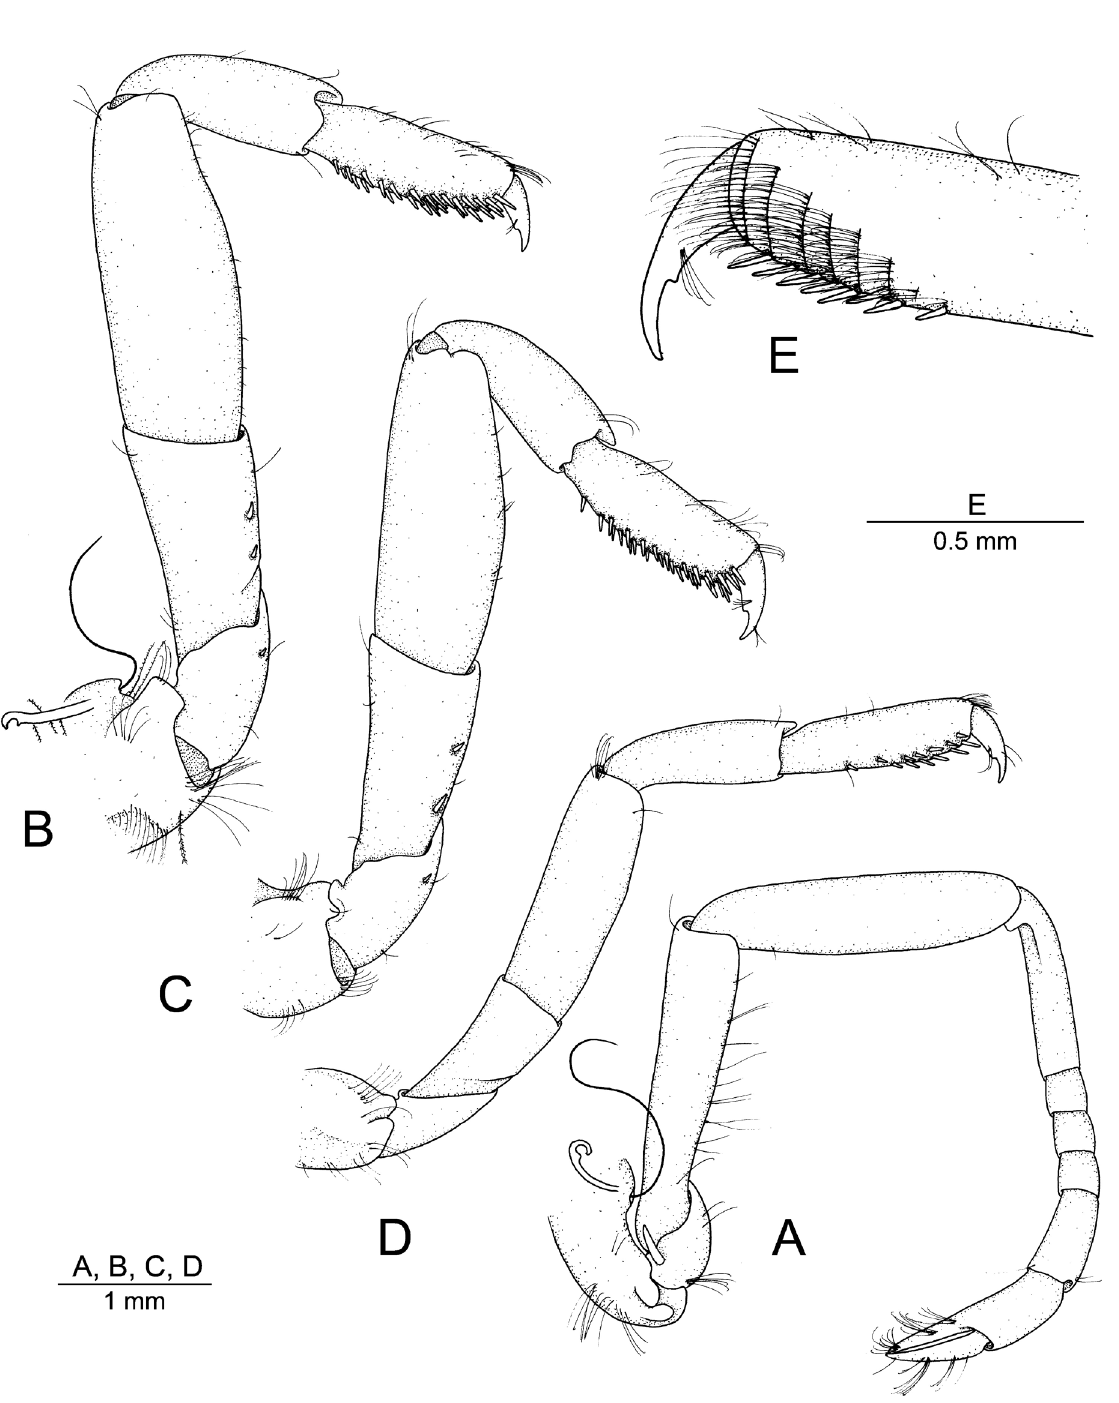
Fig. 3. Aretopsis sandybrucei sp. nov., holotype, ♂ (cl 5.31 mm) from Capel Bank, Coral Sea (MNHN-IU-2017-2924). A . Second pereiopod, lateral view. B . Third pereiopod, lateral view. C . Fourth pereiopod, lateral view. D . Fifth pereiopod, lateral view. E . Same, distal portion of propodus and dactylus, mesial